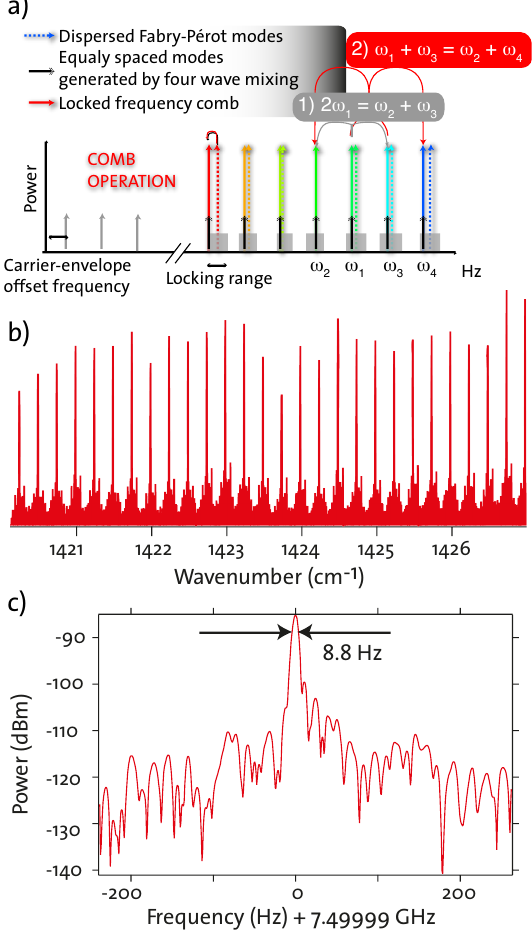
Figure 10: Principle of operation of a QCL comb: a The dispersed Fabry–Pérot resonator modes are injection-locked by the equally spaced modes generated by four-wave mixing processes. b . Mag- nified view of the optical spectrum of a QCL comb operating in the mid-infrared, at a center wavenumber of 1430cm −1 (7 µ m) cover- ing 60cm −1 . c . Radio-frequency spectrum of the intensity near the repetition frequency f rep , showing a beatnote with a full-width at half-maximum of < 10 Hz. The measurement is taken at the onset of the multimode emission and the resolution bandwidth of the spectrum analyser is set to 10Hz. Results published in